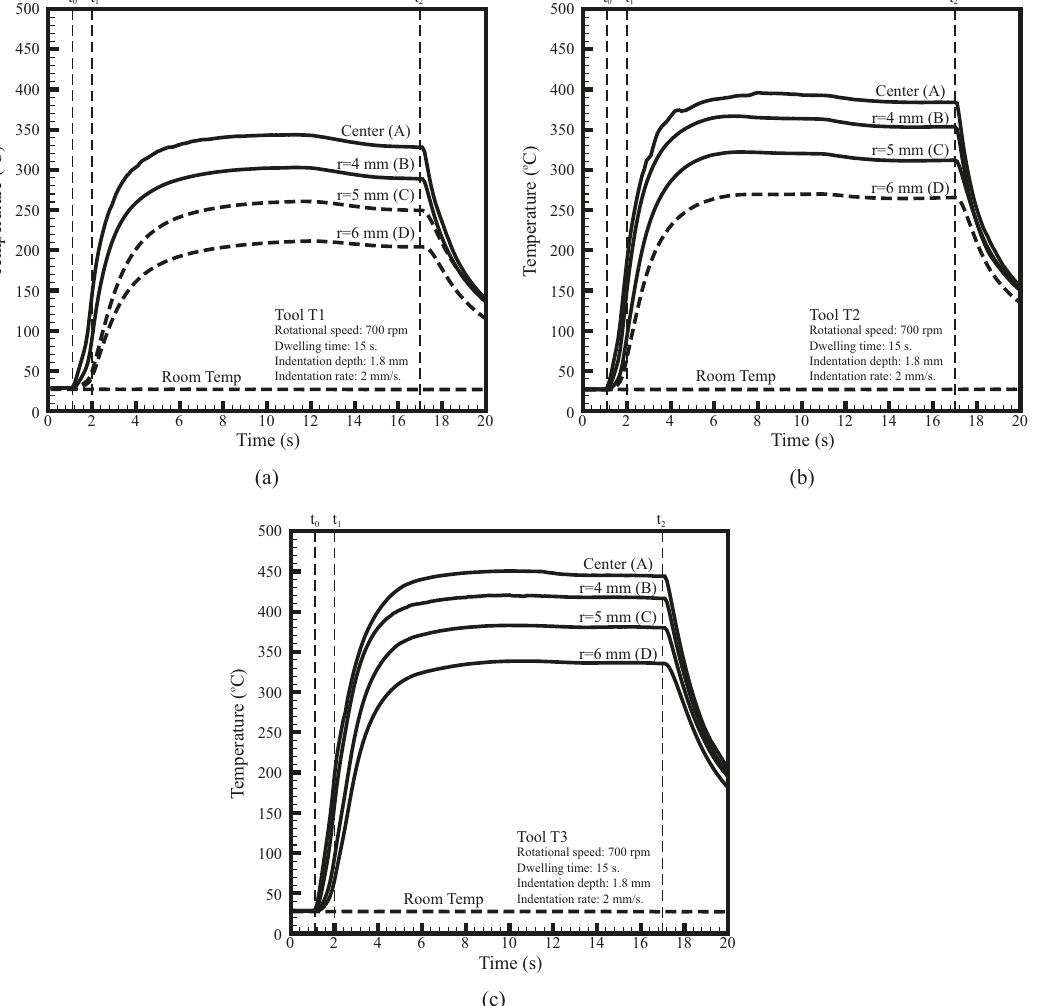
Figure 12. Temperature as functions of time at locations A, B, C, and D (Figure 4) for welds made by ( a ) T1; ( b ) T2 and ( c ) T3 tools.